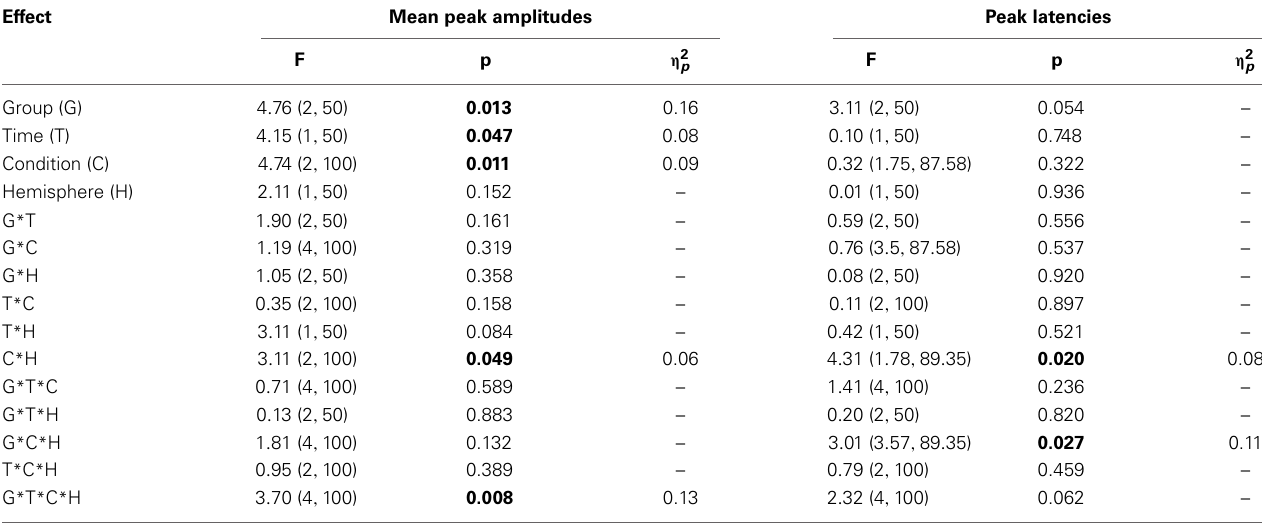
Table 4 | Results of the ANOVAs for repeated measures with F -values, p -values, and effect sizes η 2 p for the N300 mean peak amplitudes and latencies including the between-subject factor group (CON; IMP; NIMP) and the within-subject-factor time (pre; post), condition (W; PH; PW), and hemisphere (LH;